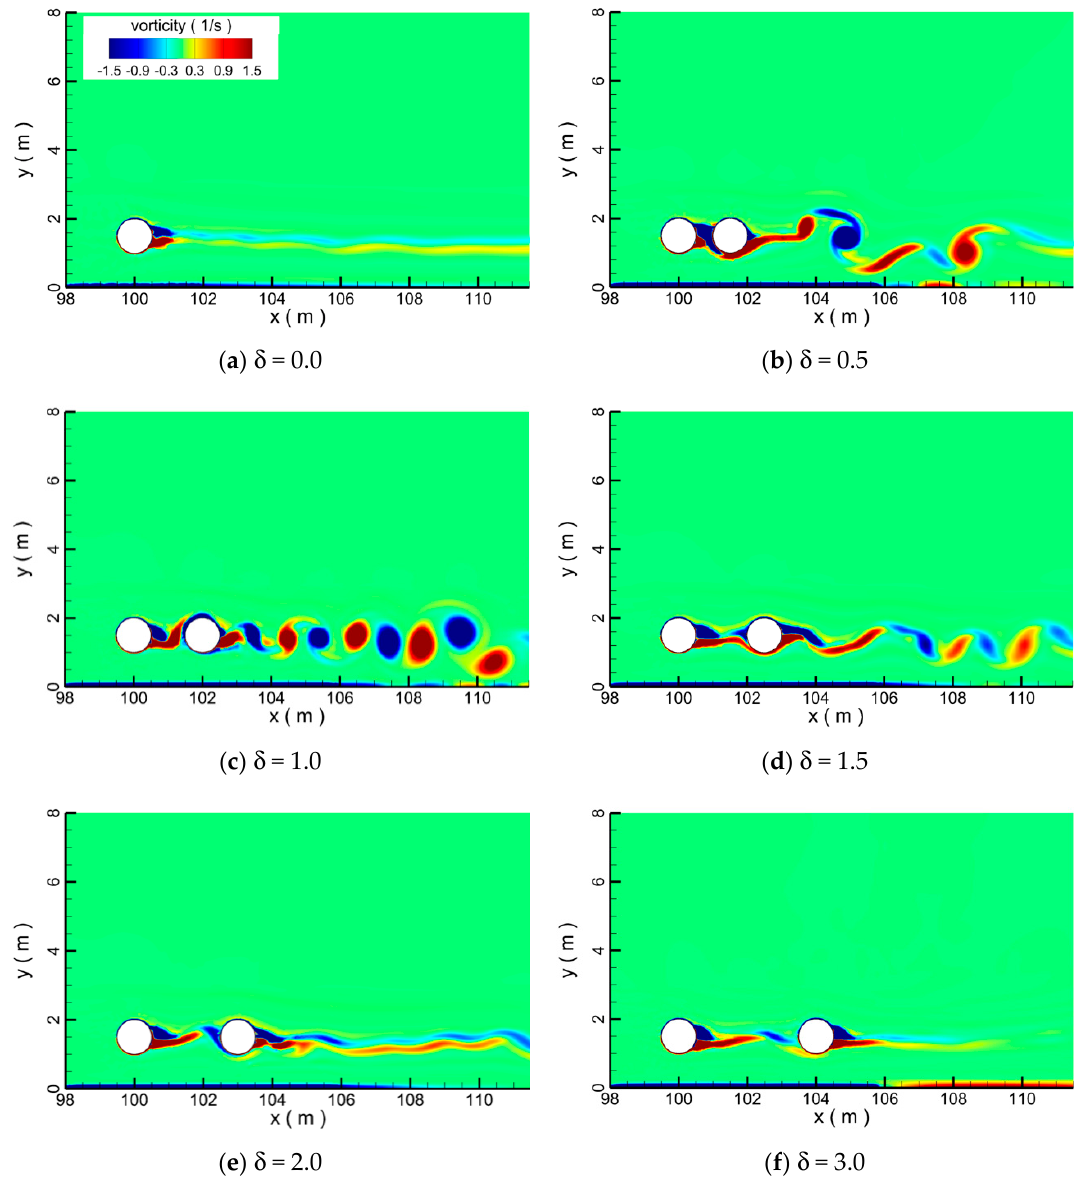
Figure 28. Snapshots of vortices contours around a tandem pipeline subjected to a tsunami-like wave at different pipeline spacing distances and t = 180 s. δ is the ratio of the distance between the two pipes to the pipeline diameter.